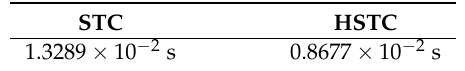
Table 3. Average computational load per run ( α = β =